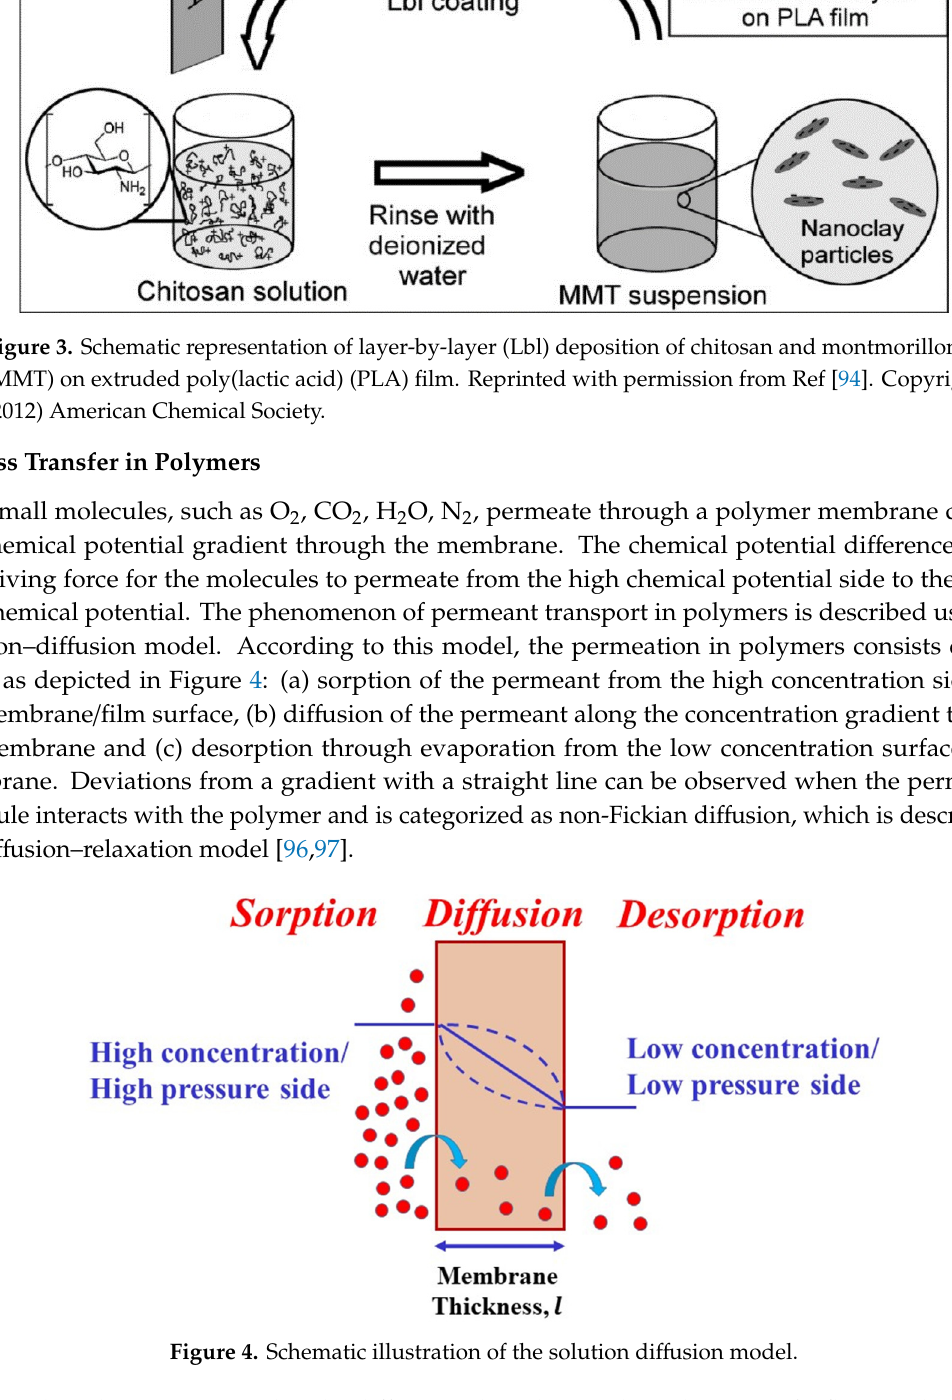
Figure 4. Schematic illustration of the solution diffusion model.